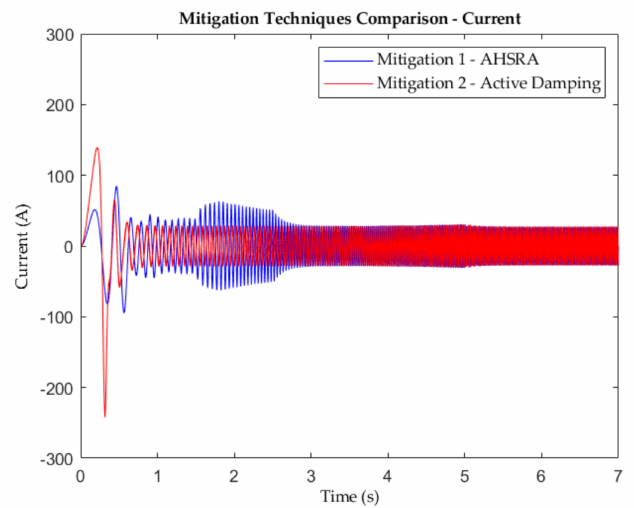
Figure 17. Stator phase A current i sA —AHSRA (blue) vs. active damping technique